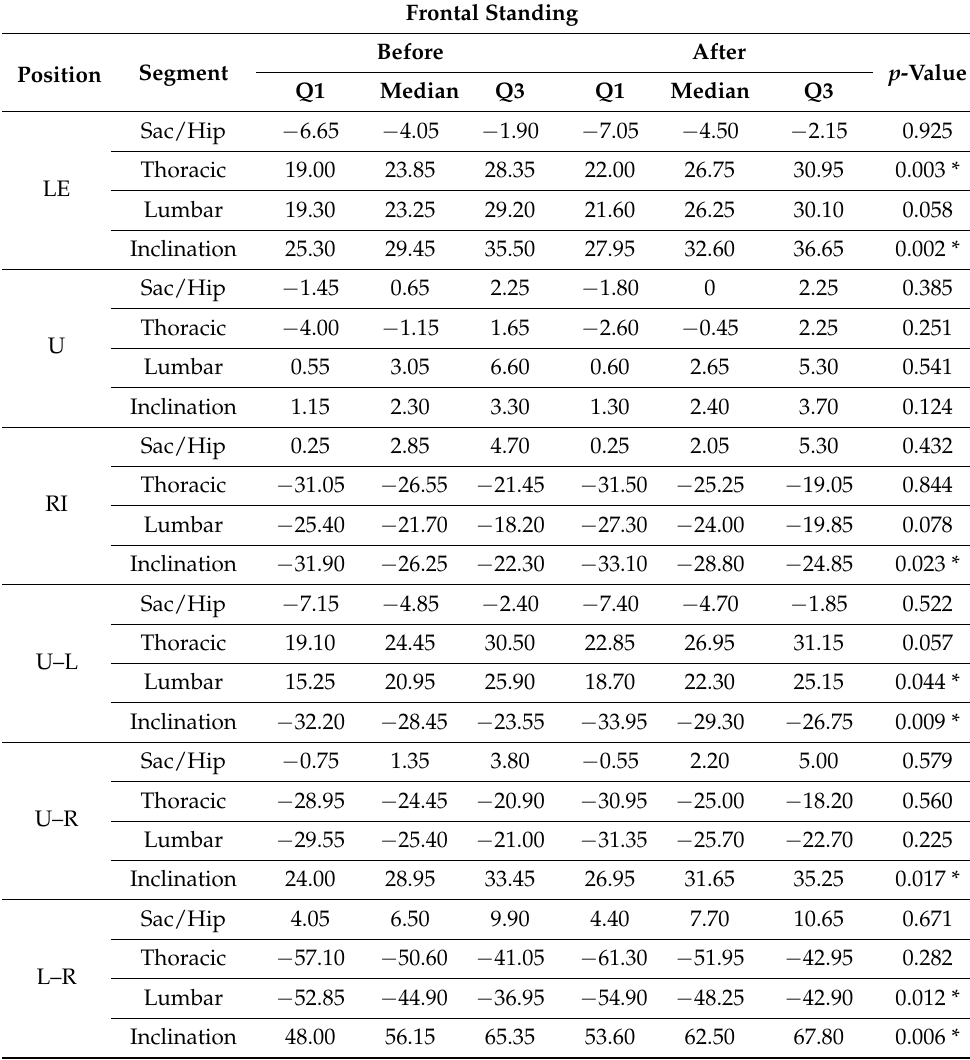
Table 5. Medians and interquartile ranges of total inclination and lumbar, thoracic and sacrum/hip inclinations in degrees measured before and after the intervention in standing position in the frontal plane: left lateral-flexion (LE), upright (U), right lateral-flexion (RI), estimated ROM from upright to flexion (U–F), upright to the left (U–E), upright to the right (U–R) and left to the right lateral-flexion (L–R) ( n =